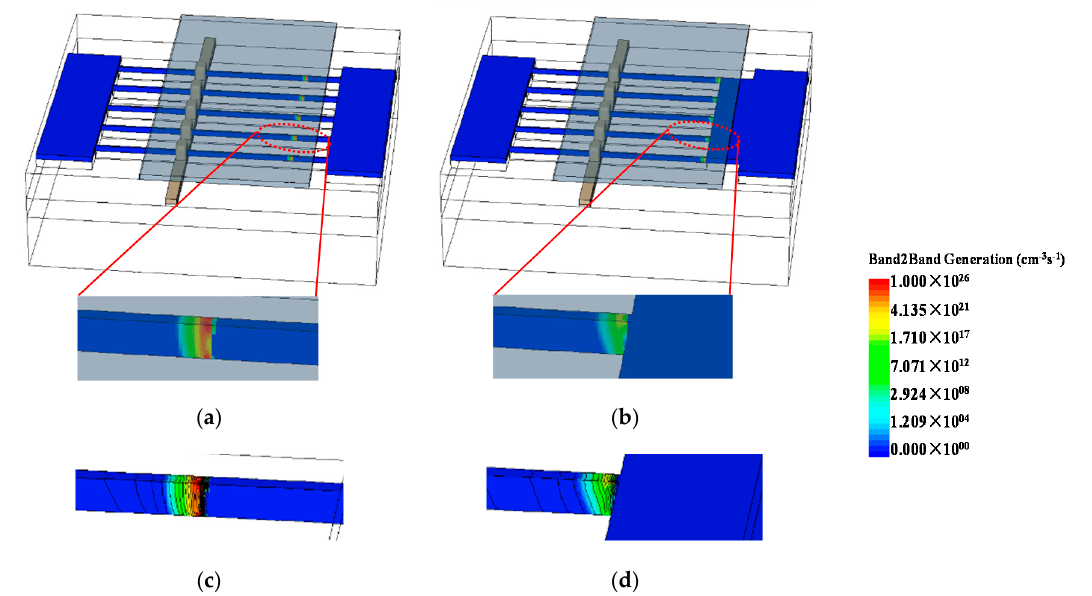
Figure 8. BTBT-GR of W40 with ( a ) L EX = 0 μ m and ( b ) L EX = 0.6 μ m and 3-D profile with electric field contours for ( c ) L EX = 0 μ m and ( d ) L EX = 0.6 μ m.